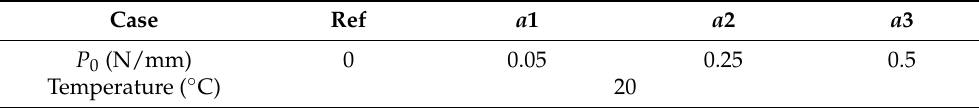
Table 4. Di ff erent cases set of static loads.